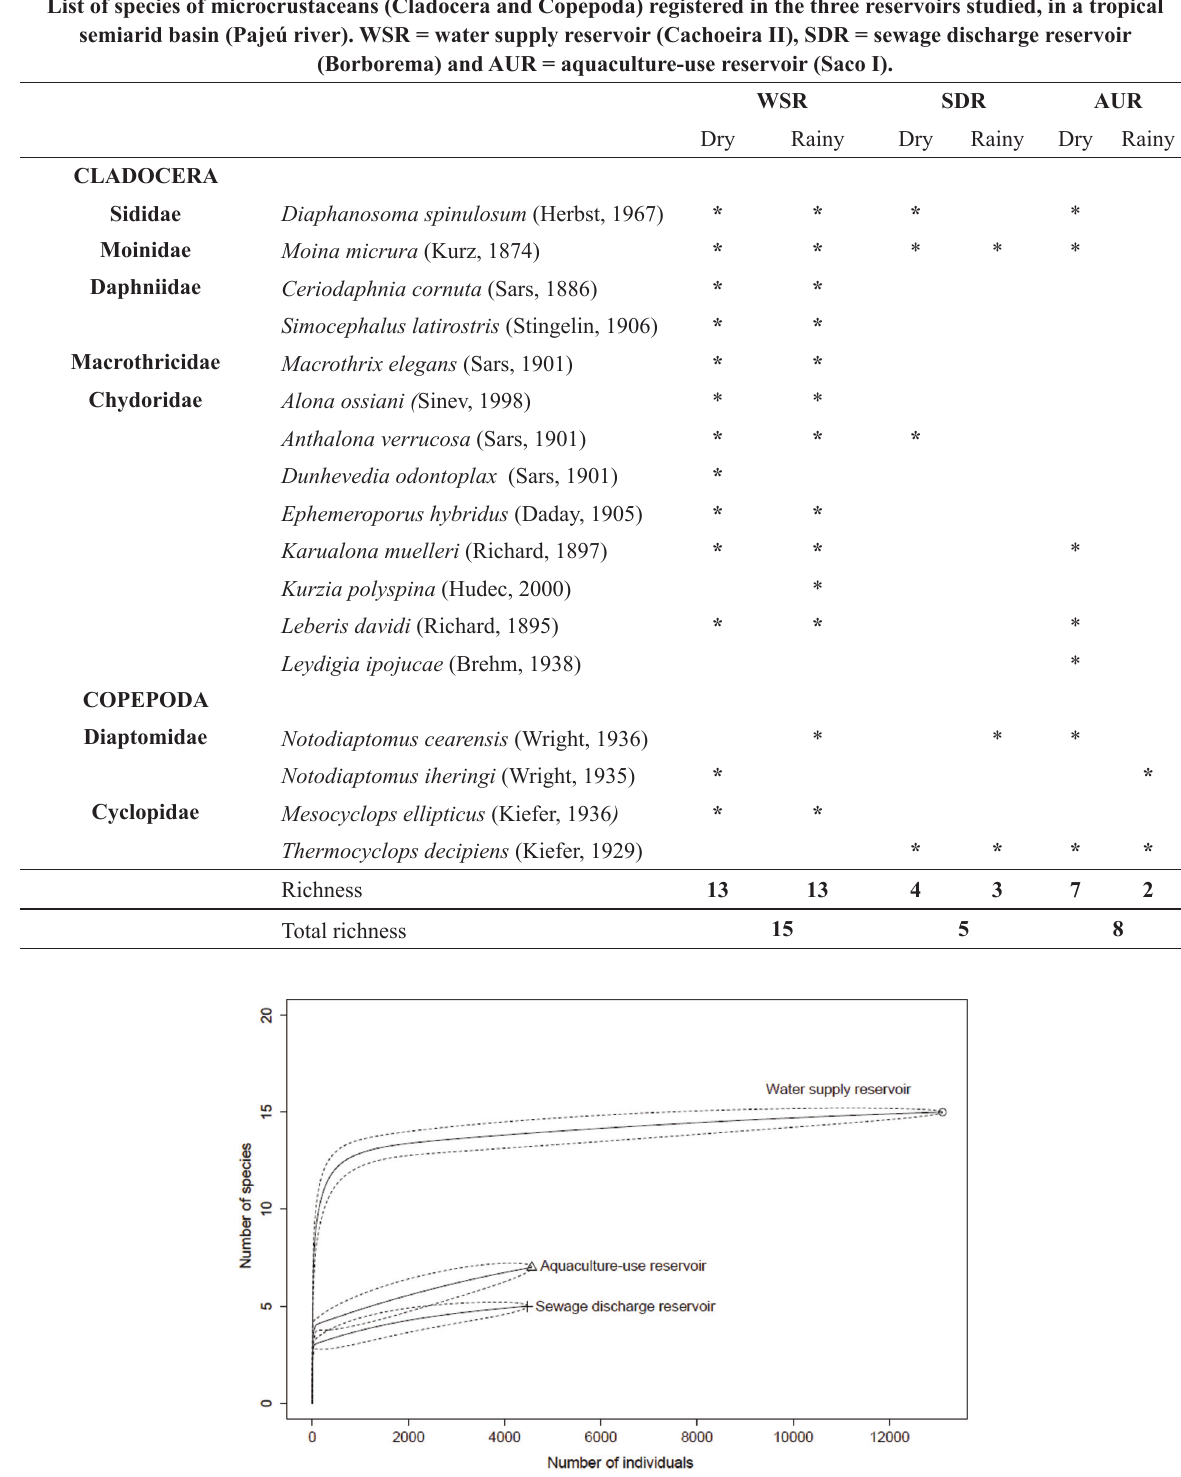
Figure 4 - Rarefaction curve based on the abundance of microcrustaceans in the three reservoirs in a tropical semiarid basin (Pajeú